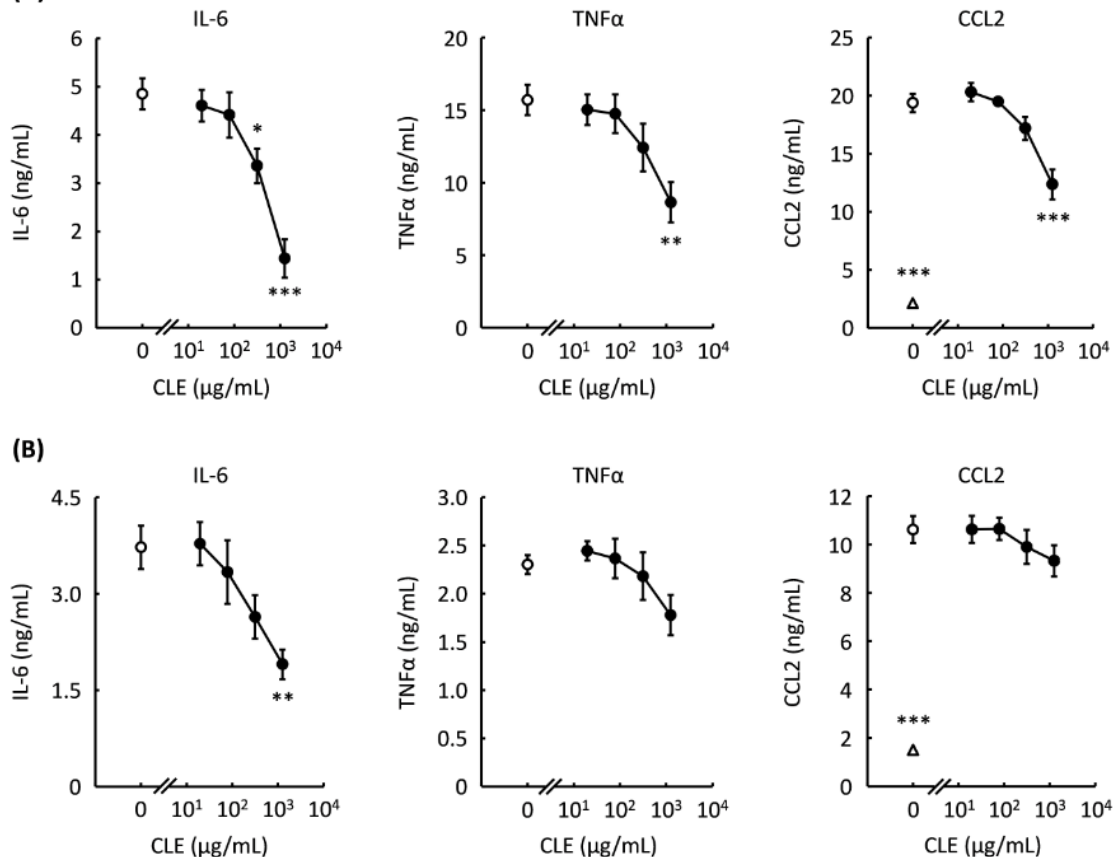
Figure 2. Effect of an aqueous extract from leaves of Citrus unshiu (CLE) on the secretion of proinflammatory proteins from RAW 264.7 cells and mouse peritoneal macrophages. RAW 264.7 cells and mouse peritoneal macrophages were treated with various concentrations of CLE for 24 h, followed by LPS stimulation for 6 h. The culture medium was subsequently used for measuring the concentrations of IL-6, TNF α , and CCL2 by ELISA kits. An open circle indicates the LPS-stimulated cells treated with water instead of CLE (control). An open triangle indicates the cells not stimulated with LPS. The concentrations of IL-6 and TNF α secreted from the cells not stimulated with LPS were below the limit of quantitation. Data are represented as mean ± SEM of three independent experiments. * p < 0.05, ** p < 0.01, or *** p < 0.001 against control by Dunnett’s test. RAW 264.7 cells ( A ), peritoneal macrophages ( B